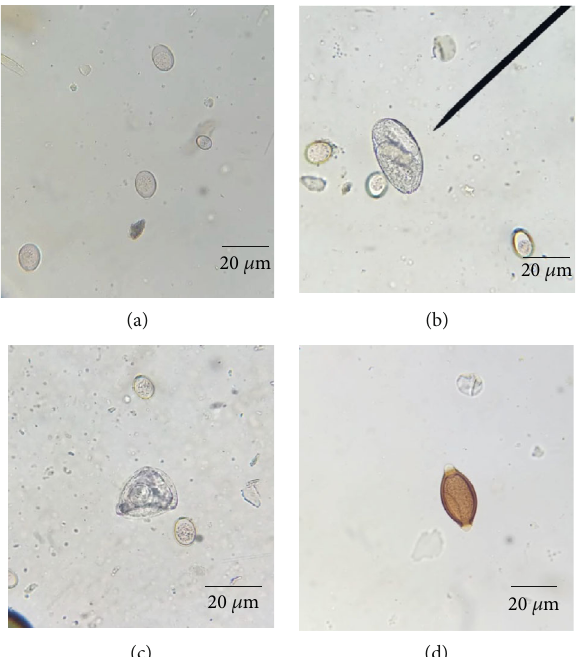
Figure 3: Parasite oocyst/eggs of goat: (a) Eimeria spp. ( × 400), (b) Trichostrongyle spp. ( × 400), (c) Moniezia expa nsa ( × 100), and (d) Trichuris spp. ( ×